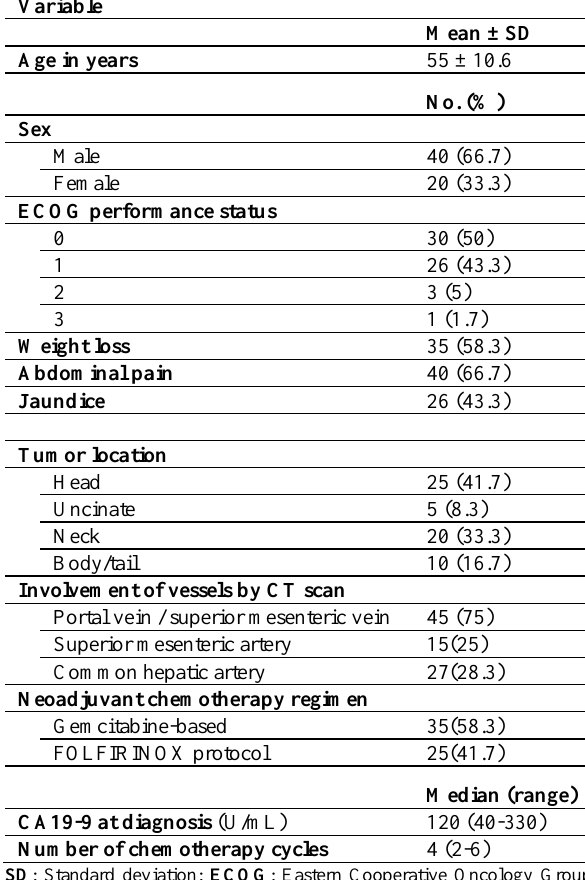
Table 1. Patient’s Baseline